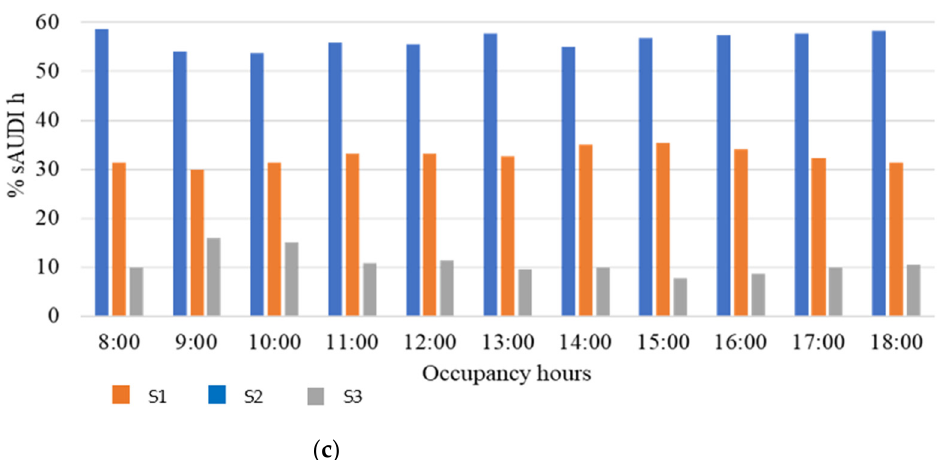
Figure 6. The %sAUDIh associated with s 1 , s 2 , and s 3 for horizontal responsive louvers with opti- mum angles for south, east, north, and west facades on 21 June in Phoenix. ( a ) East, ( b ) West, ( c ) North.